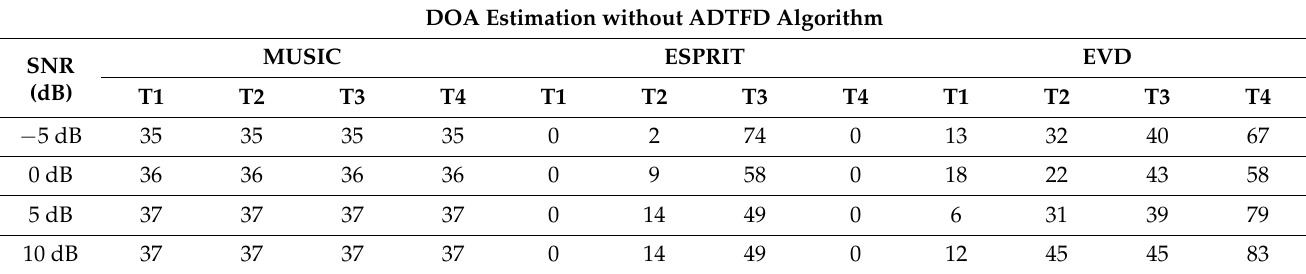
Table 1. DOA estimation results without using the ADTFD algorithm.